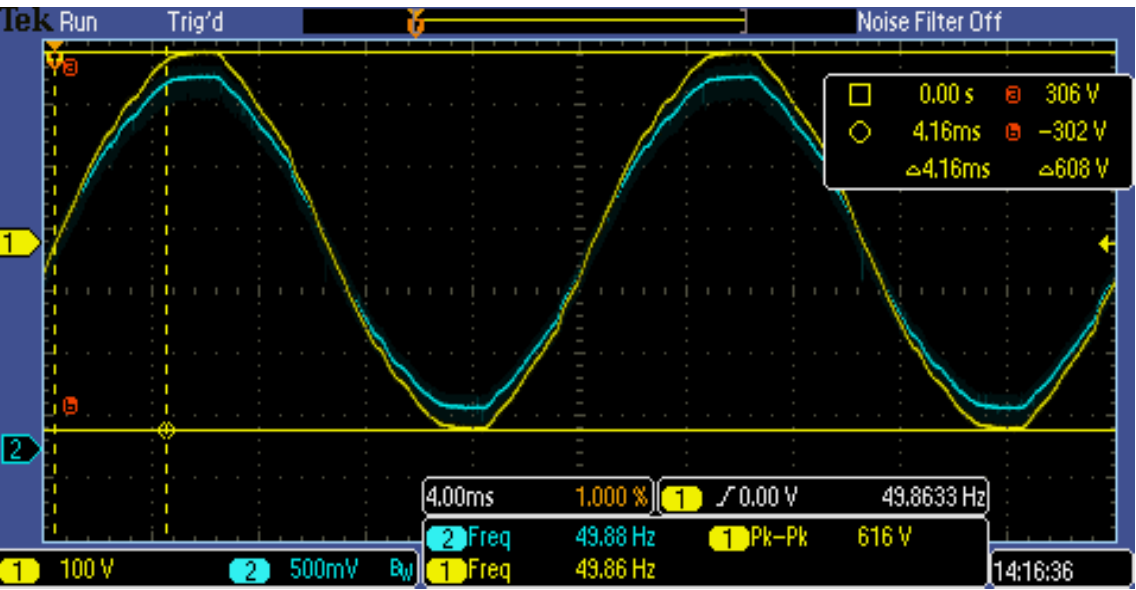
Figure 25. Oscilloscope capture of 3.2 kHz falling edge timing after PPS signal.